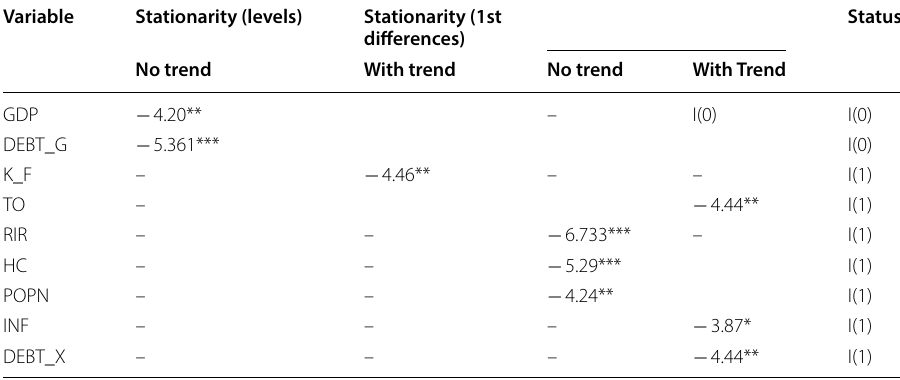
Table 3 The augmented Dickey–Fuller test results for stationarity (Unit roots